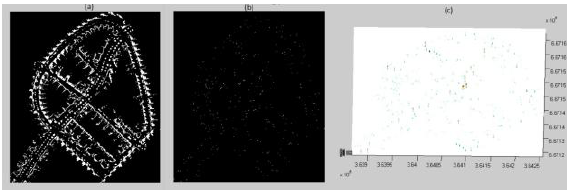
Figure 6. UAV image block Figure 4. The process of pole extraction UAV images were taken in every second, with an overlap of 80% in both side overlap and forward overlap. These images were taken from different views. The images with known camera calibration parameters (focal length of camera, principal points of image and system errors: lens distortion and deformation) can be referenced to each other and be